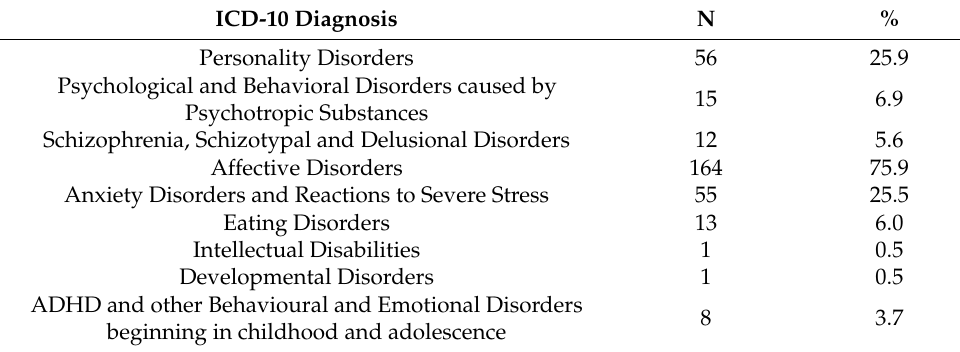
Table 1. Distribution of ICD-10 diagnoses among mentally ill parents.